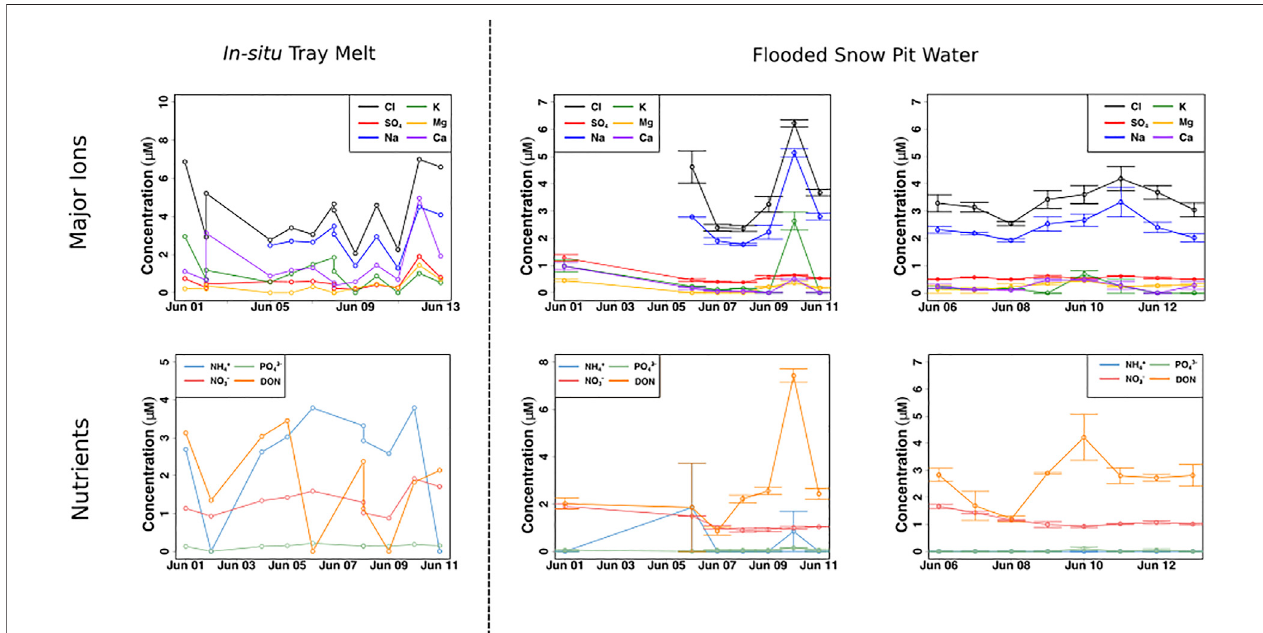
FIGURE6 | Far-leftpanel portrays meltwater concentrationsof chloride (Cl − ),sulfate (SO 42 − ), sodium (Na + ),potassium (K + ),magnesium (Mg 2+ ) and calcium (Ca 2+ ) from the in-situ tray snowmelt ( n = 1). The centre and far-right fi gures portray mean ± SE ammonium (NH 4+ ), nitrate (NO 3 − ), phosphate (PO 43 − ) and dissolved organic nitrogen (DON) concentrations of the fl ooded snow pit meltwater ( n = 2).